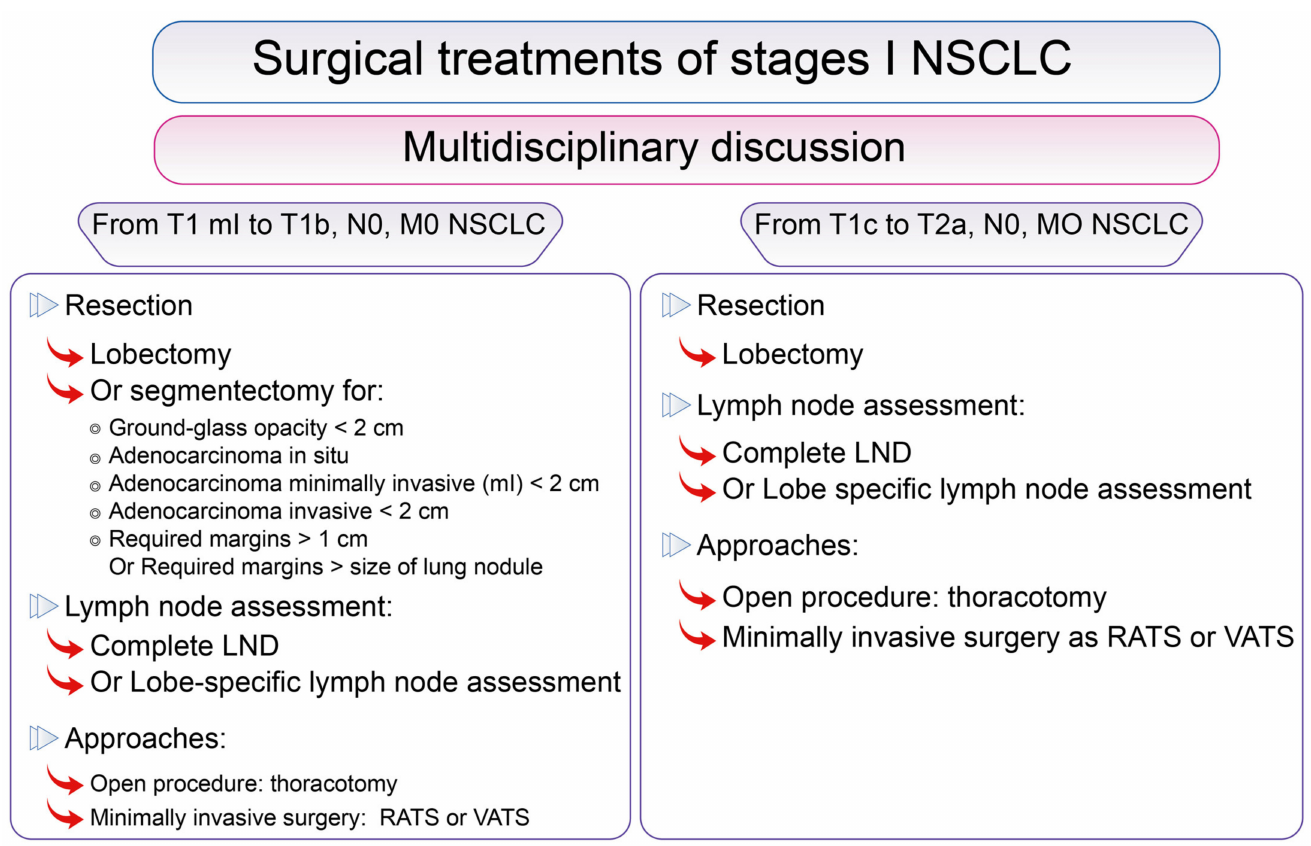
Figure 3. Surgical options and treatments for resectable Stage I lung cancer. Surgical options and treatments according to lung cancer stage in the lung cancer Stage I group according to the 8th Edition of the TNM classification of lung cancers